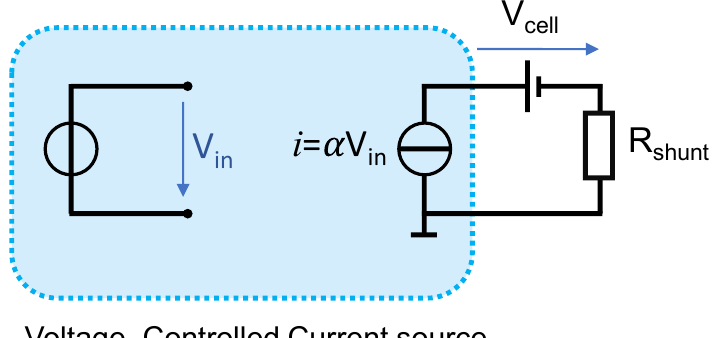
Figure 9. Voltage-Controlled Current Source